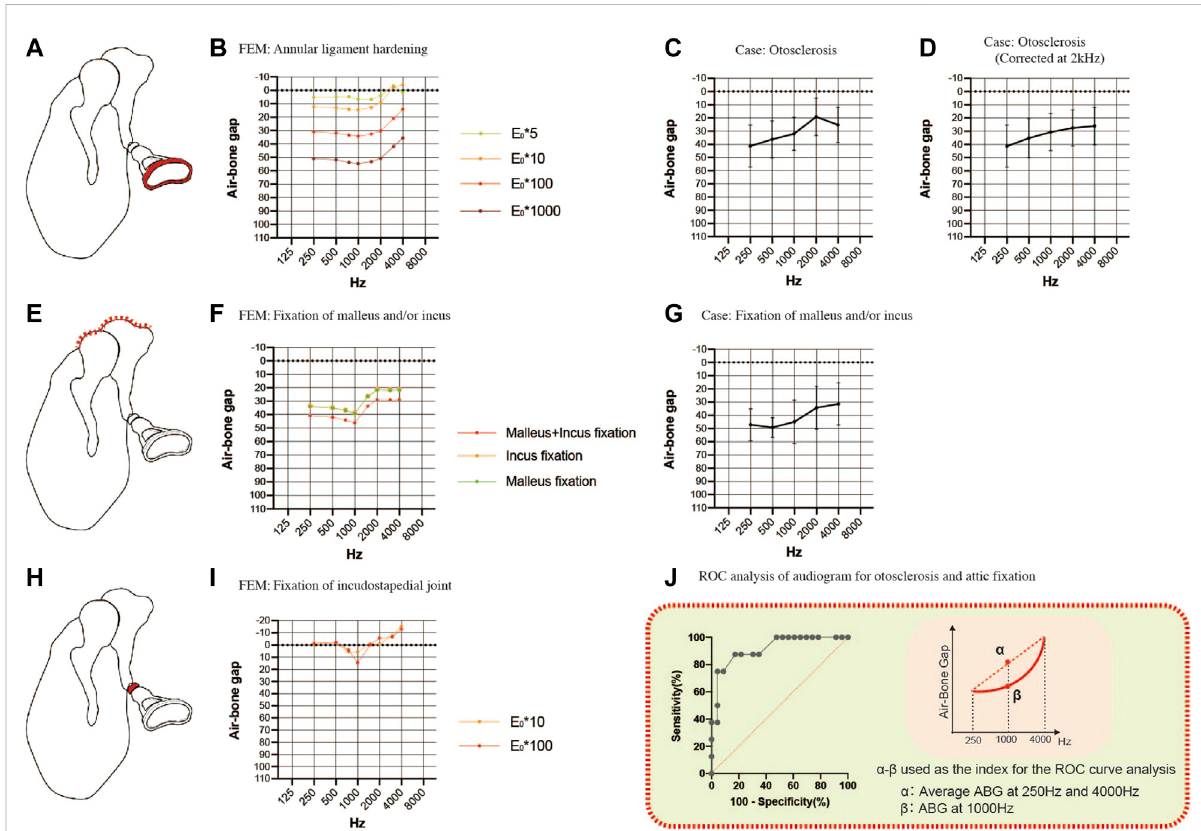
FIGURE 4 Comparisonsoftheair-bonegaps(ABGs)forscleroticpathologiesbetweentheFEMandclinicalcases. (A) Schematicshowingannularligament hardening (red). (B) Audiogram simulated using the FEM of annular ligament hardening. (C) Averaged audiogram obtained from 24 cases with otosclerosis.ThemeanABGwas29.1±10.9 dBHL( n =24). (D) Smoothcurveobtainedwhentheaudiogramin (C) wascorrectedforthe2 kHzbone conductionthreshold. (E) Schematicshowing fi xation ofthe malleus and/or incus (red). (F) Audiogram simulated usingthe FEMofmalleusand/ or incus fi xation. (G) Averaged audiogram obtained from 7 patients with fi xation of the malleus and/or incus. The mean ABG was 42.9 ± 11.2 dB HL ( n = 7). (H) Schematic showing fi xation of the incudostapedial joint (red). (I) Audiogram simulated using the FEM of incudostapedial joint hardening. (J) Although both otosclerosis and attic fi xation were associated with an up-sloping audiogram, these two pathologies could be differentiated from each other by calculating the difference between the ABG at 1000 Hz and the mean of the ABGs at 250 and 4000 Hz. Receiver operating characteristic (ROC) curve analysis determined that the optimum cut-off value for this parameter was 13.8 dB HL (area under the curve: 0.916; p = 0.0006). (E) Young ’ s